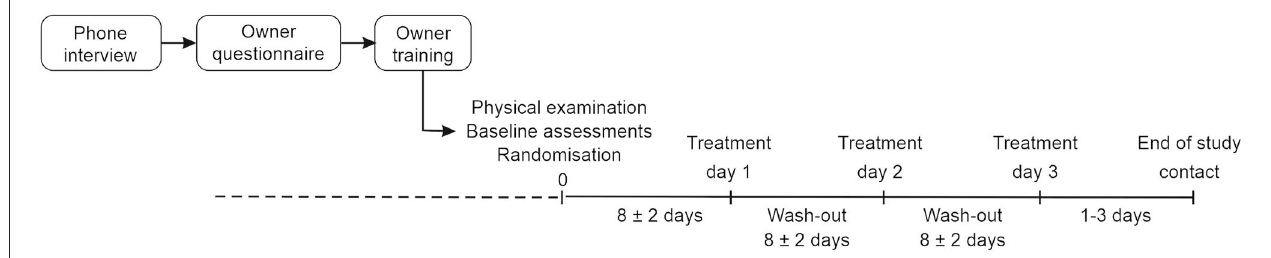
TABLE 1 | Rating of the signs of distress, anxiety, and/or fear by the cat owner. Numerical rating Severity 0 Absent